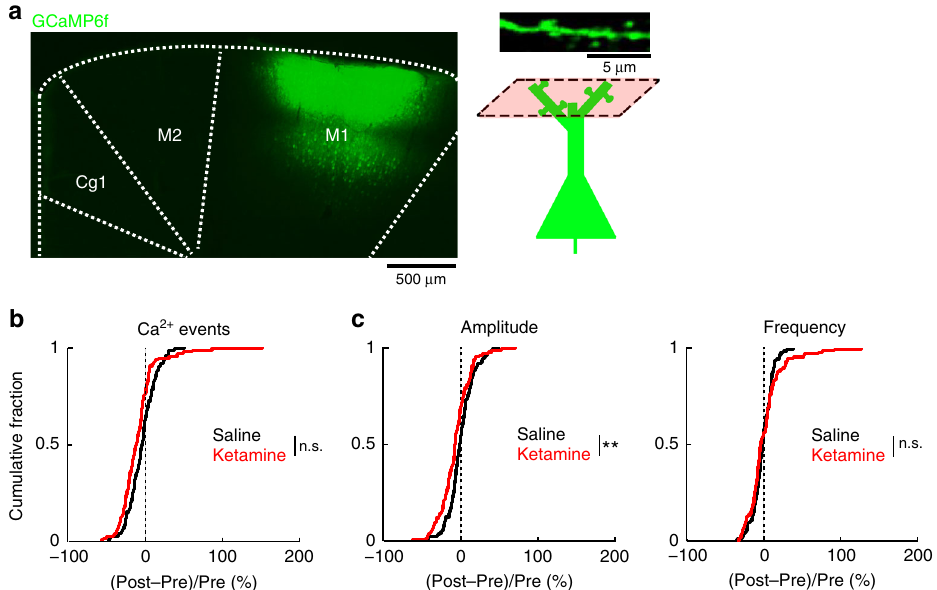
Fig. 3 Effect of ketamine on calcium dynamics for dendritic spines in the primary motor cortex. a Left, coronal histological section, showing the extent of AAV-mediated expression of GCaMP6f in the primary motor cortex, M1. Right, schematic of imaging location. b The normalized difference in the rate of spontaneous calcium events for apical dendritic spines in M1. Normalized difference was calculated as post-injection minus pre-injection values normalized by the pre-injection value (ketamine (10 mg/kg): − 7 ± 2%, mean ± s.e.m.; saline: − 2 ± 2% for saline; P = 0.05, two-sample t -test). For ketamine, n = 124 dendritic spines from 3 animals. For saline, n = 120 dendritic spines from 3 animals. c The normalized difference in amplitude (ketamine (10 mg/kg): − 7 ± 2%; saline: − 5 ± 2%; P = 0.004, two-sample t -test) and frequency of binned calcium events (2 ± 2% for ketamine; − 1 ± 1% for saline; P = 0.3, two-sample t -test). * P < 0.05; ** P < 0.01; *** P < 0.001; n.s., not signi fi cant.